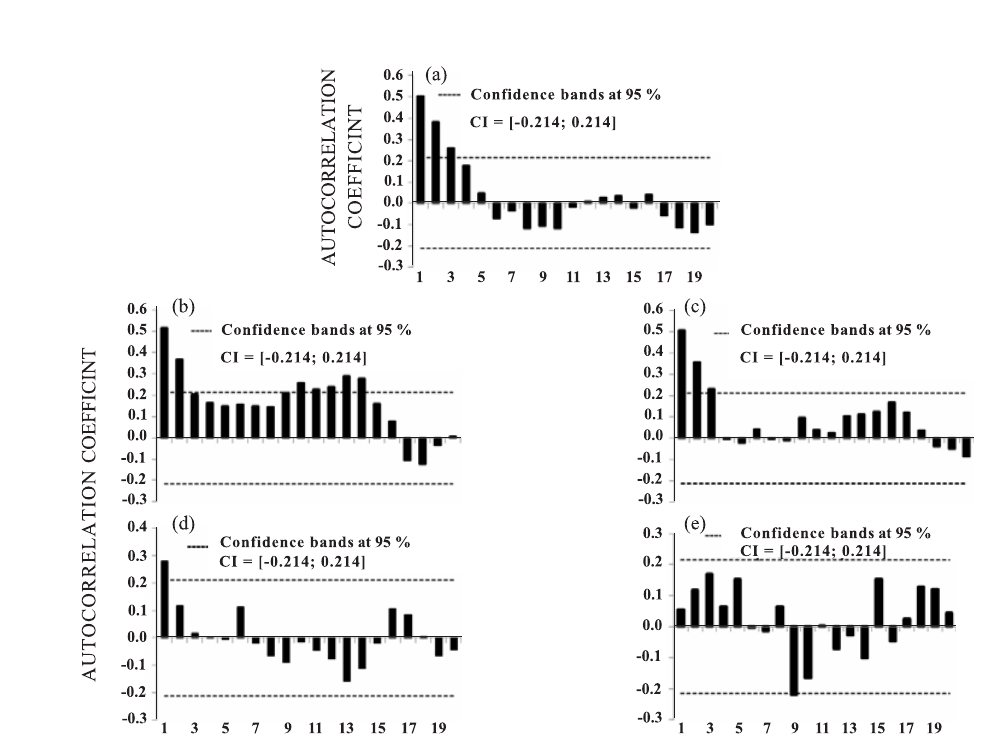
Figure 2. Autocorrelographs: (a) soybean yield data; (b) soil penetration resistance data in the 0–0.10 m layer; (c) soil penetration resistance data in the 0.10–0.20 m layer; (d) soil bulk density data in the 0– 0.10 m layer; and (e) soil bulk density data in the 0.10–0.20 m